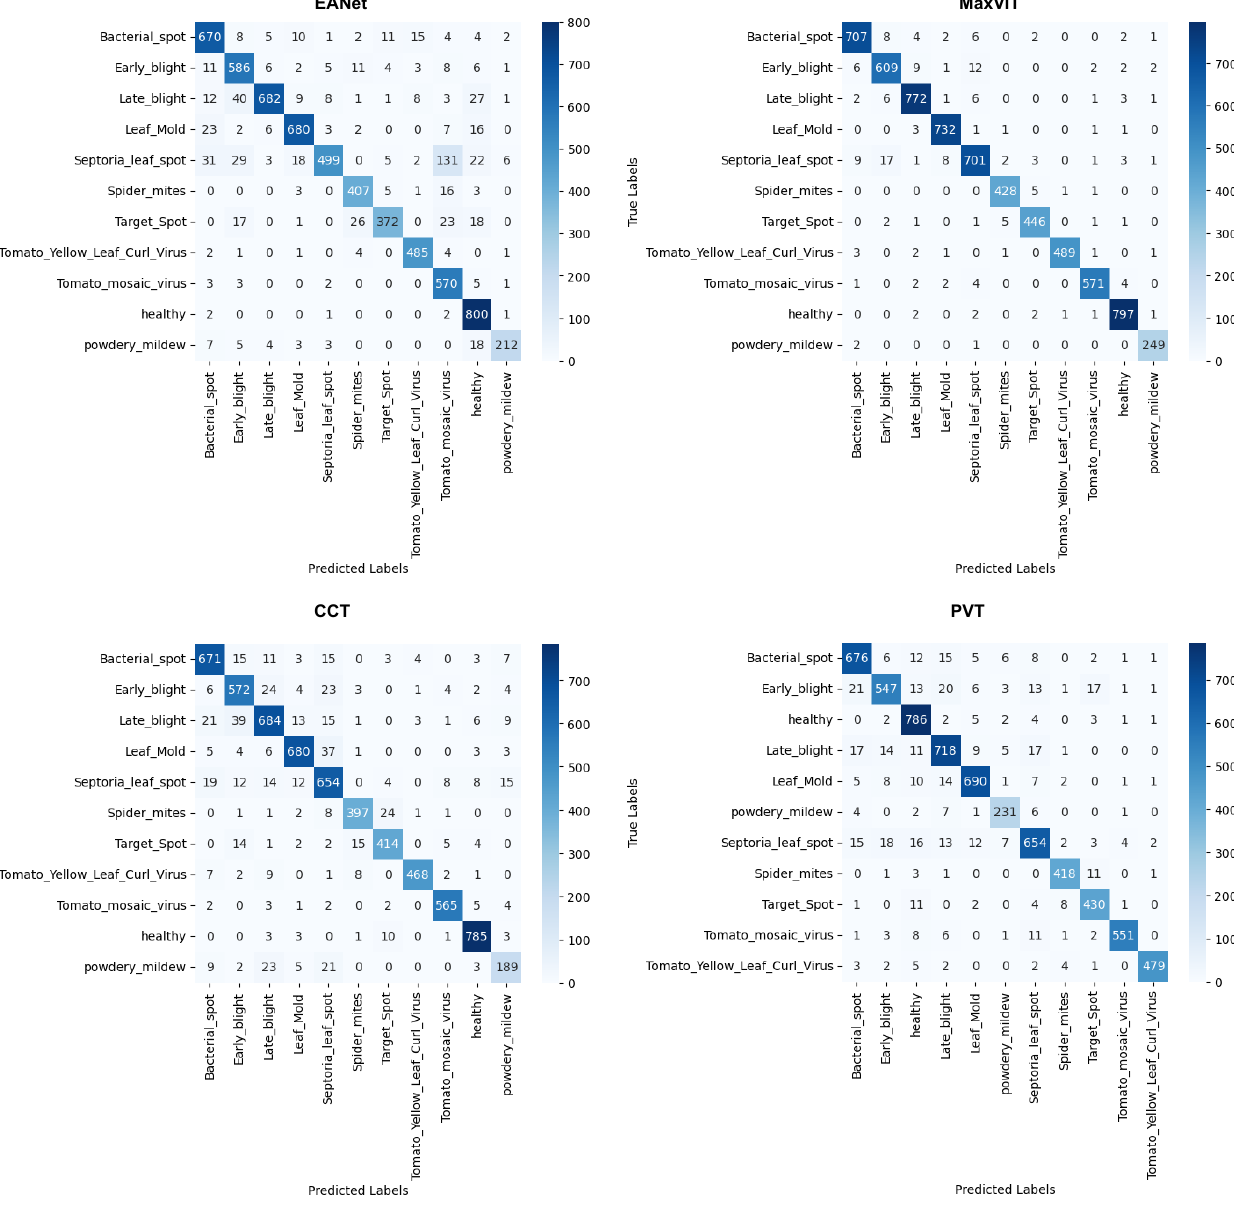
Figure 11. Confusion